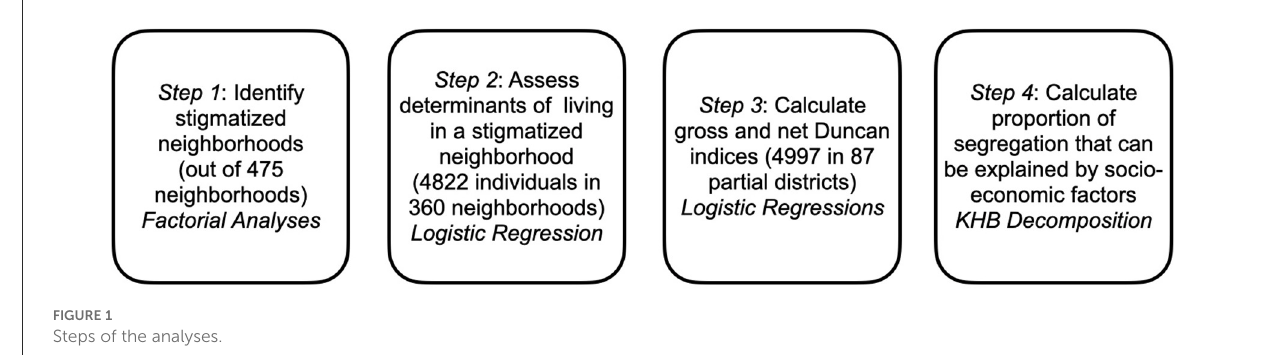
FIGURE1 Steps of the